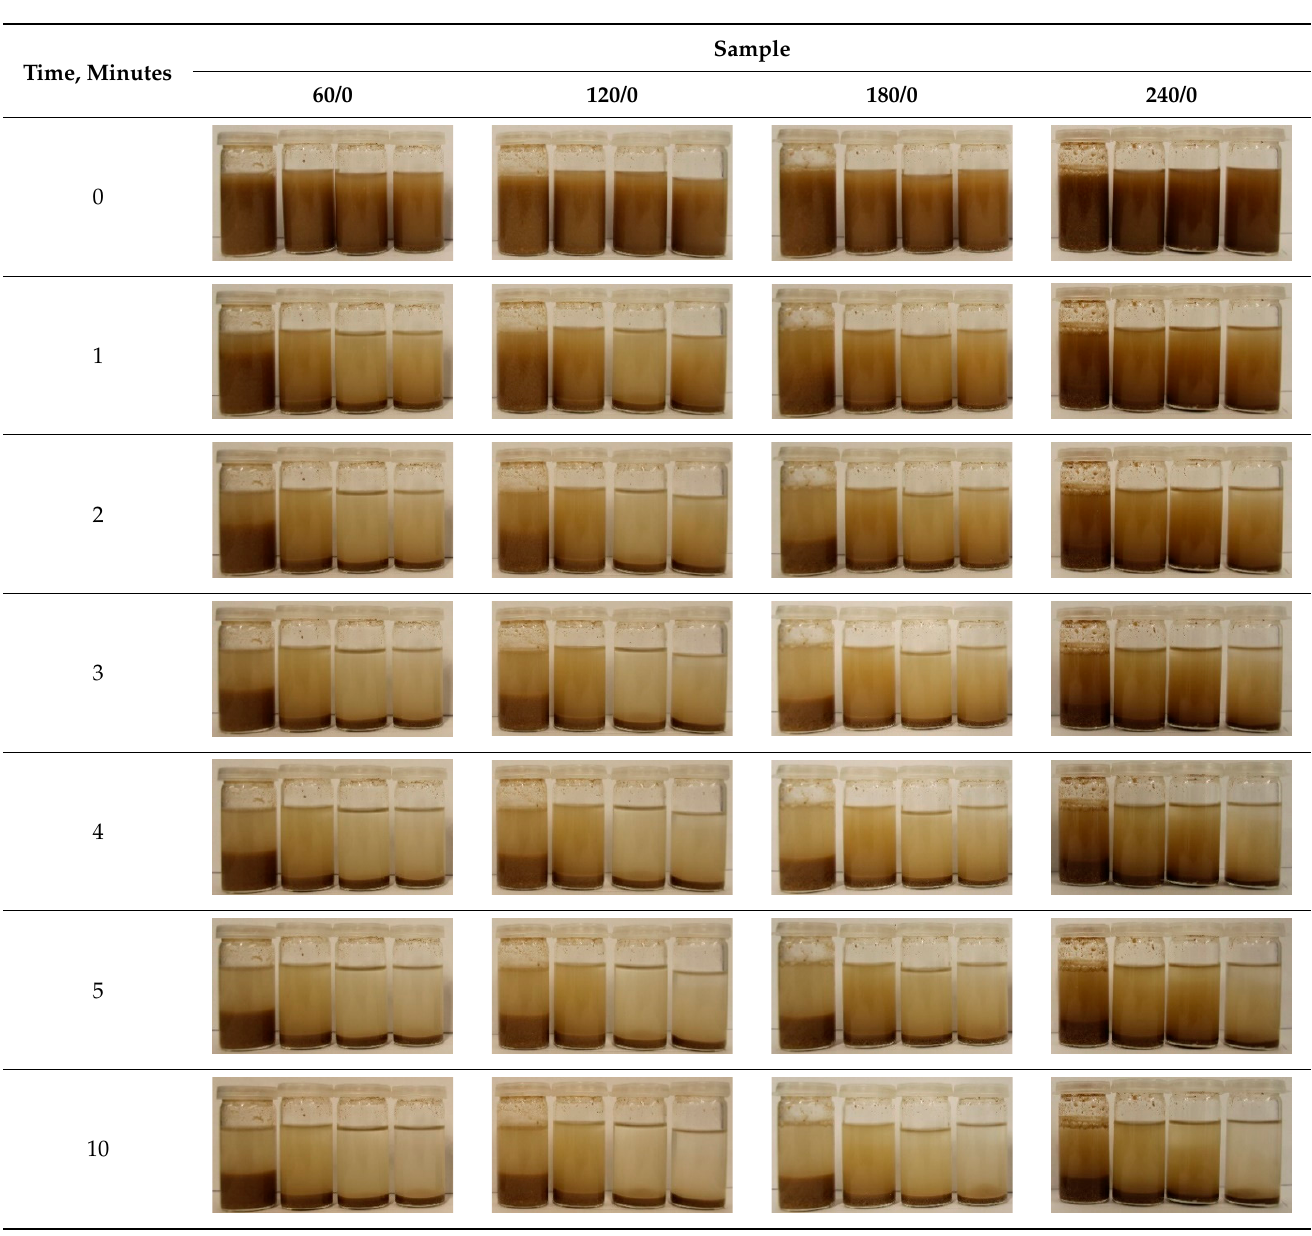
7 of 24 characterized by different polarities. In all photographs, the solvents are ordered in the following manner—water, methanol, acetone, and n -pentane (from left to right).